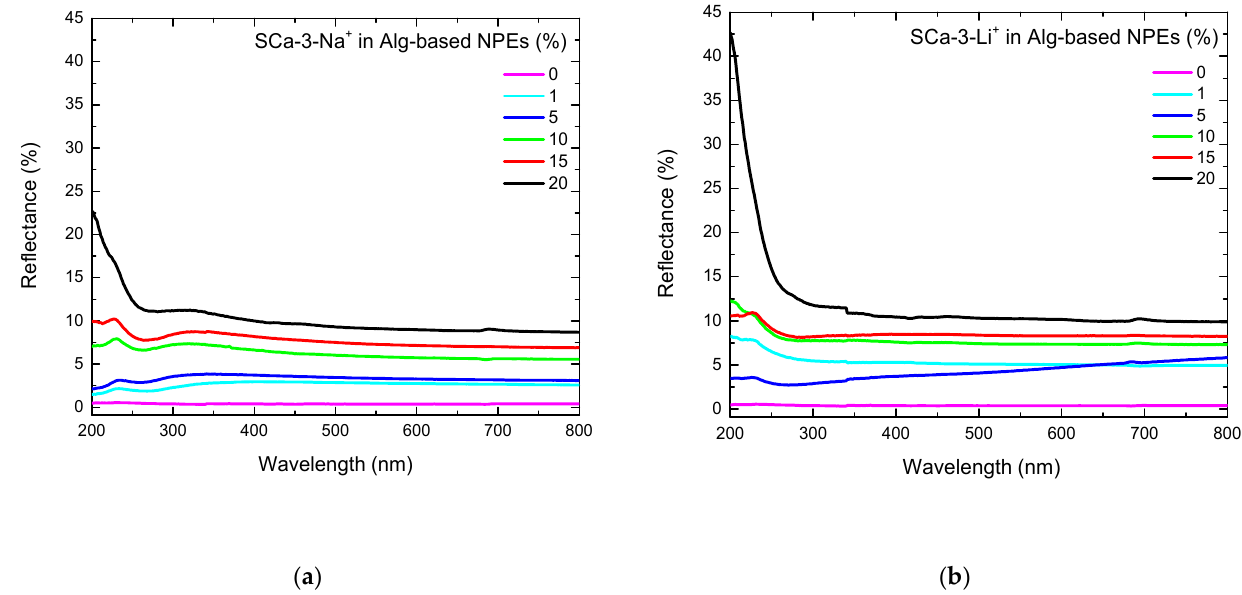
Figure 4. Reflectance spectra for Alg-based NPEs with 0–20 wt% of ( a ) SCa-3-Na + and ( b ) SCa-3-Li + .